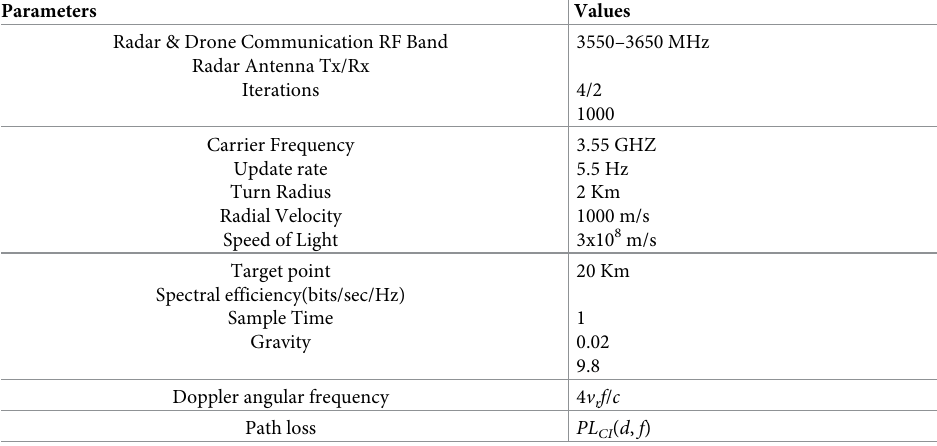
Table 1. Massive MIMO radar parameters for test